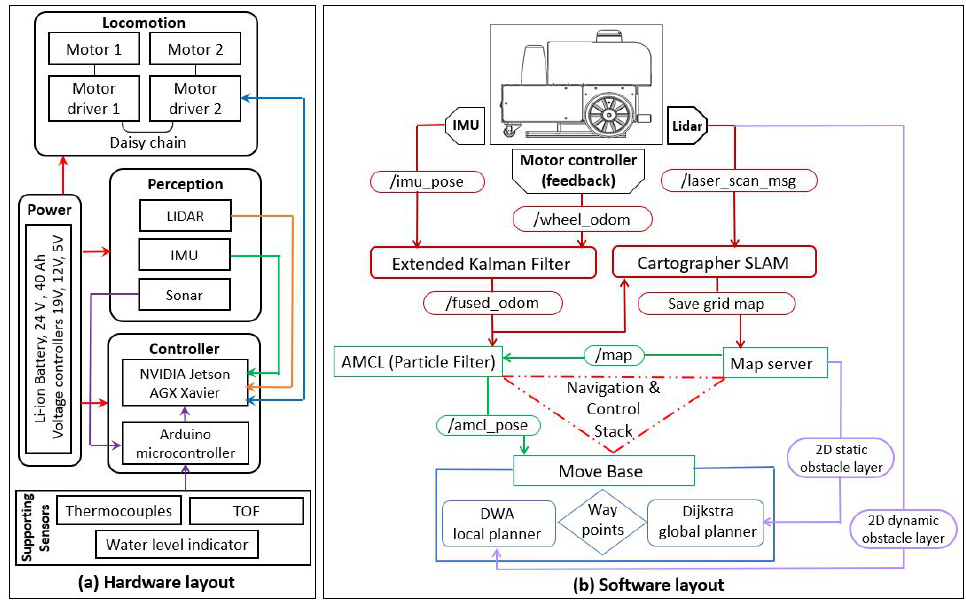
Figure 6. System